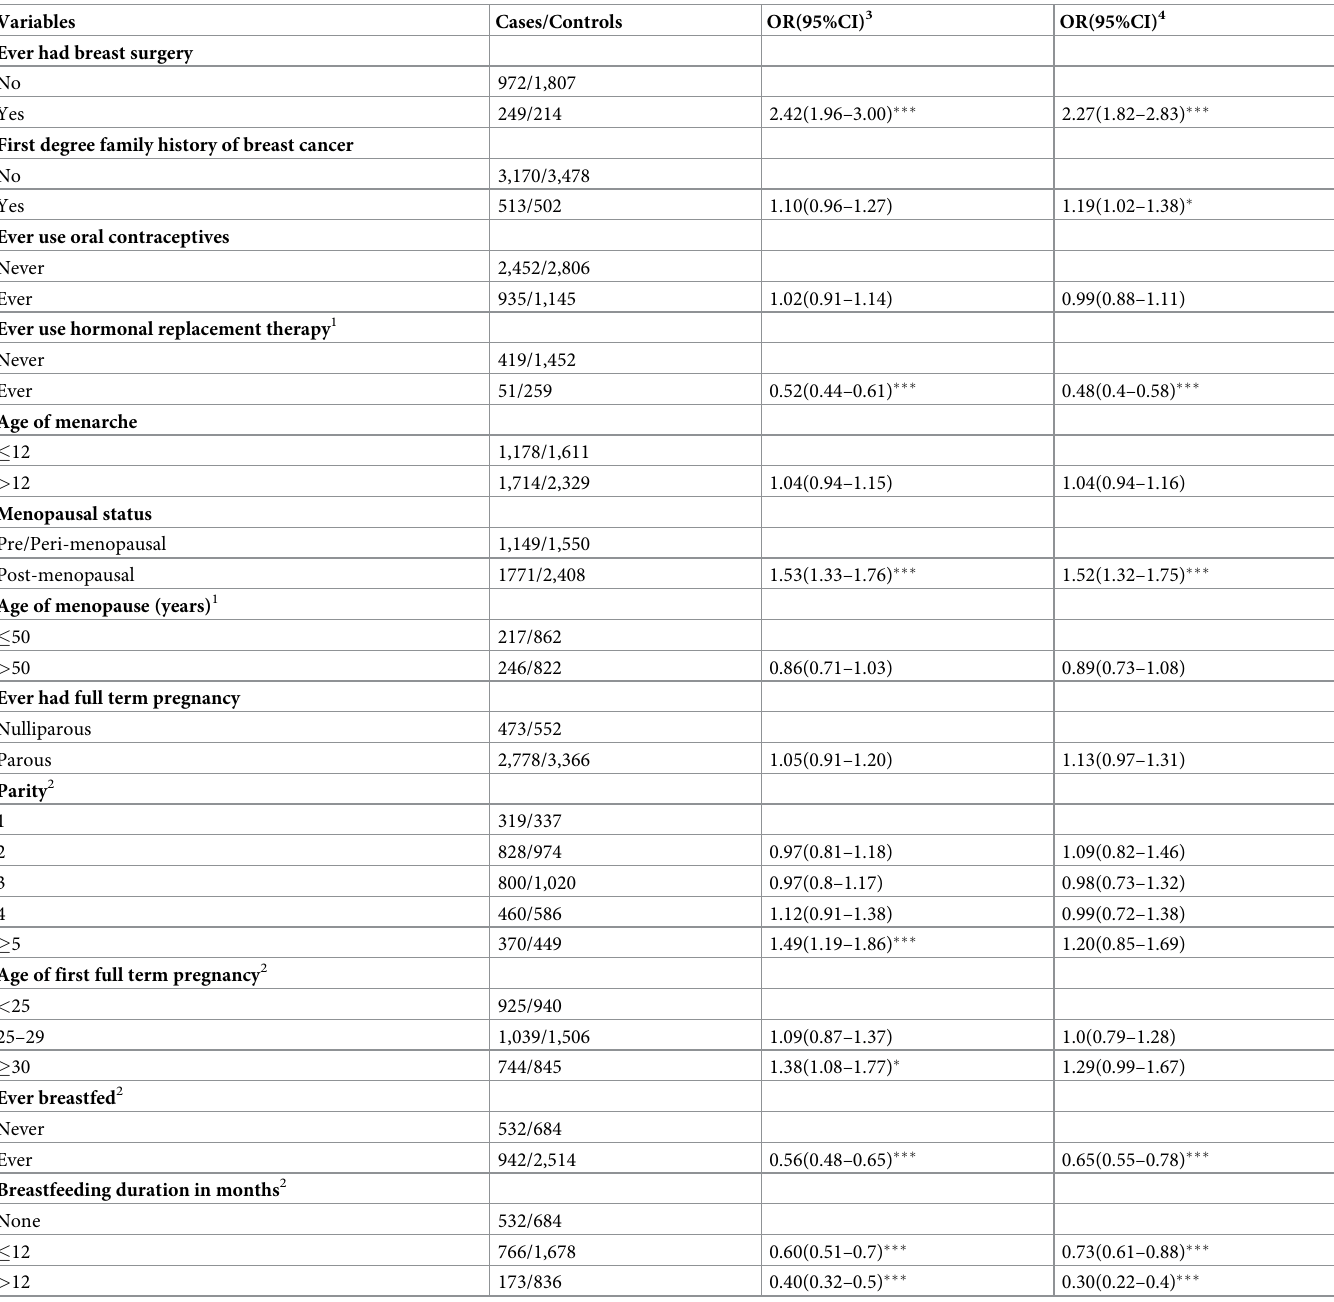
Table 2. Clinical, exogenous hormonal, and menstrual and reproductive factors and their association with breast